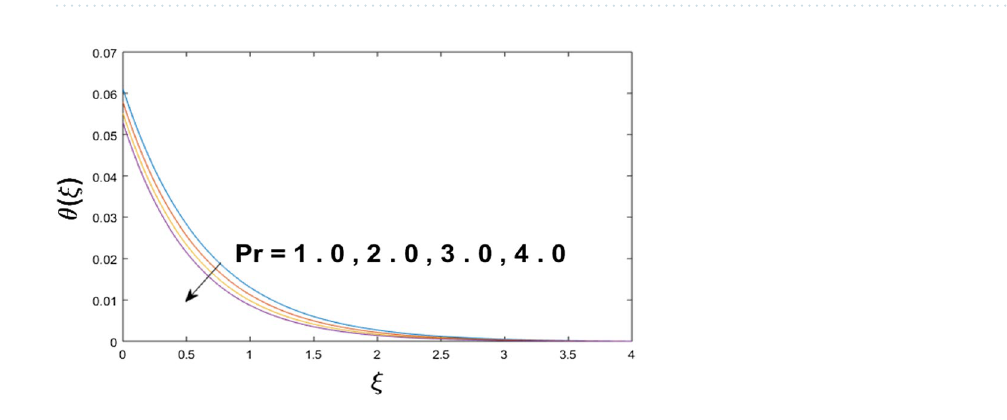
Figure 10. Variations of Pr to θ(ξ) .